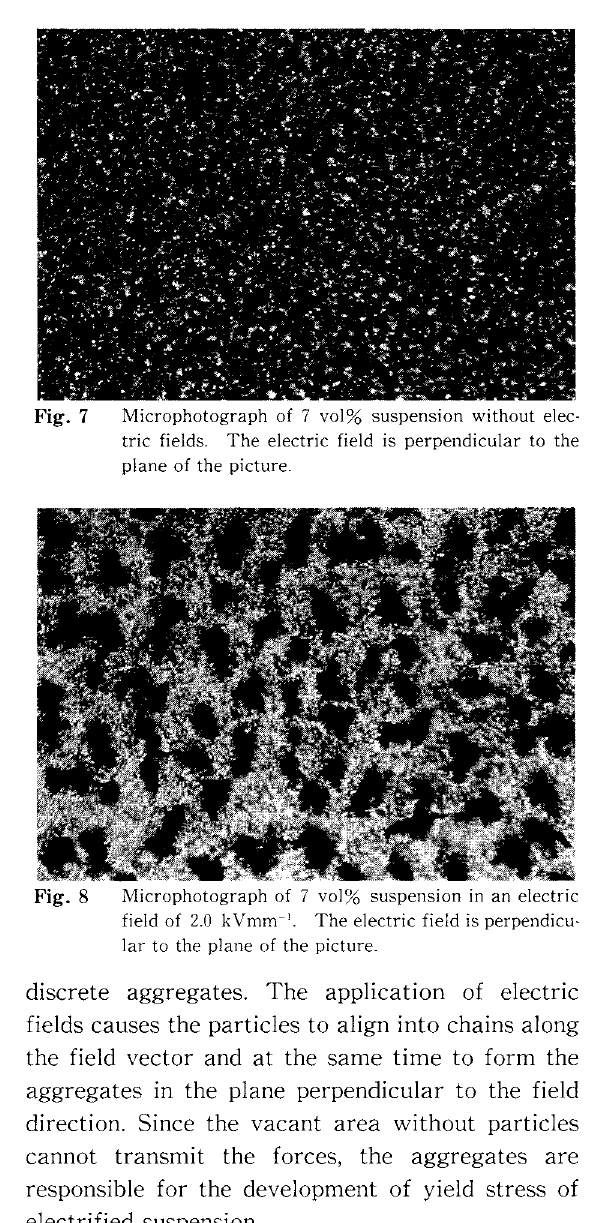
Fig. 7 Microphotograph of 7 vol% suspension without elec tric fields. The electric field is perpendicular to the plane of the picture.